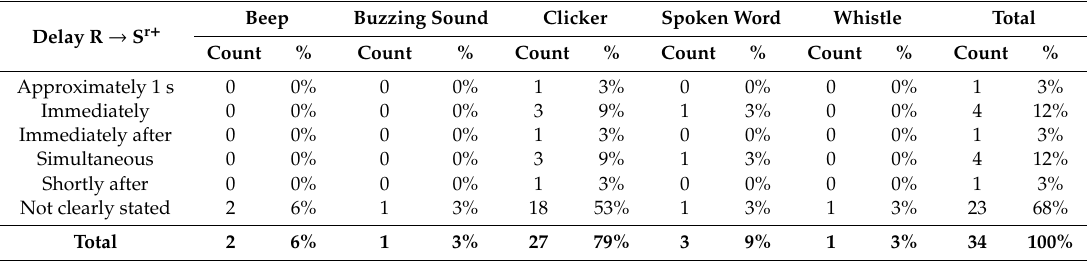
Note: Percentages may not total 100% due to